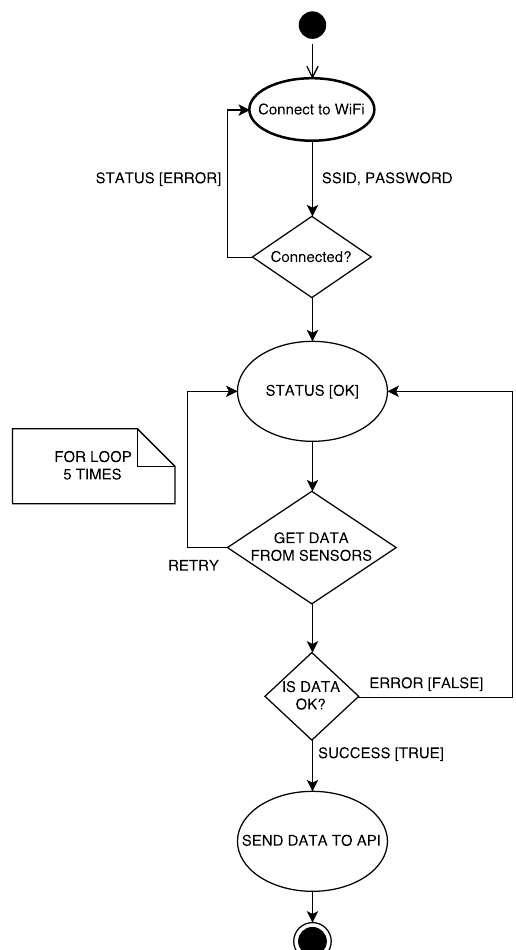
Figure 6. ESP8266 activity diagram for the sensor data